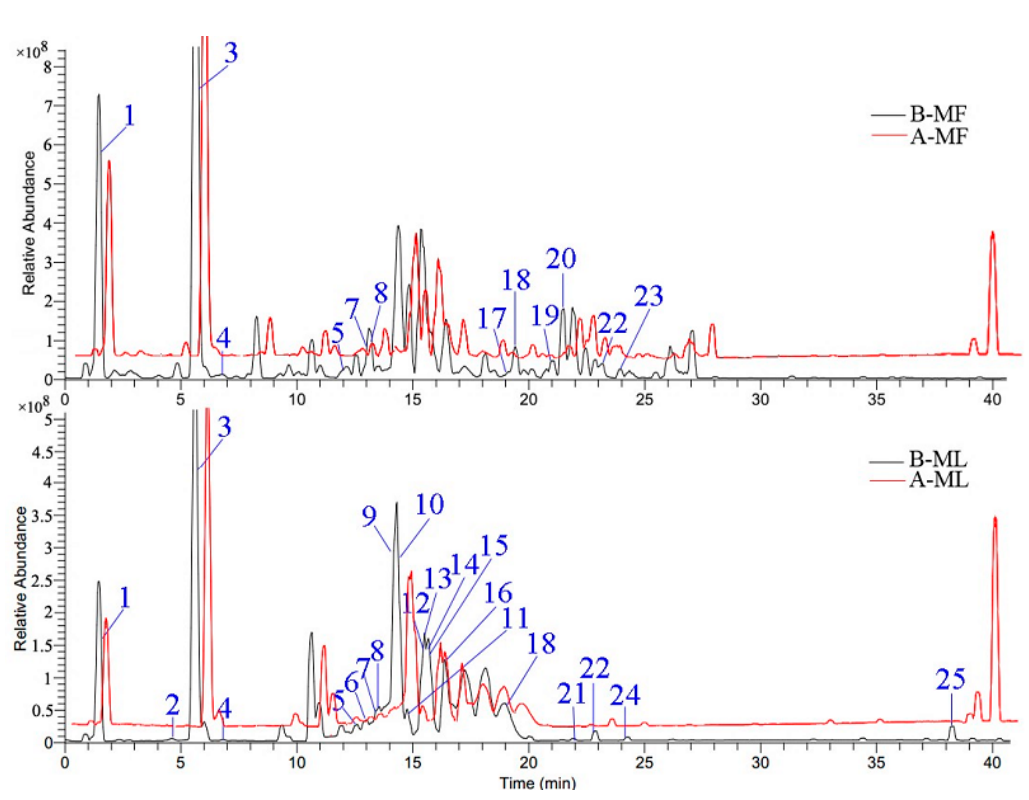
Figure 2. Base peak chromatogram (BPC) of the extracts from Paeonia rockii flowers and leaves (negative mode). B-MF: Methanol extracts from flowers without reaction with DPPH; A-MF: Methanol extracts from flowers reacted with DPPH; B-ML: Methanol extracts from leaves without reaction with DPPH; A-ML: Methanol extracts of leaves after reaction with DPPH.